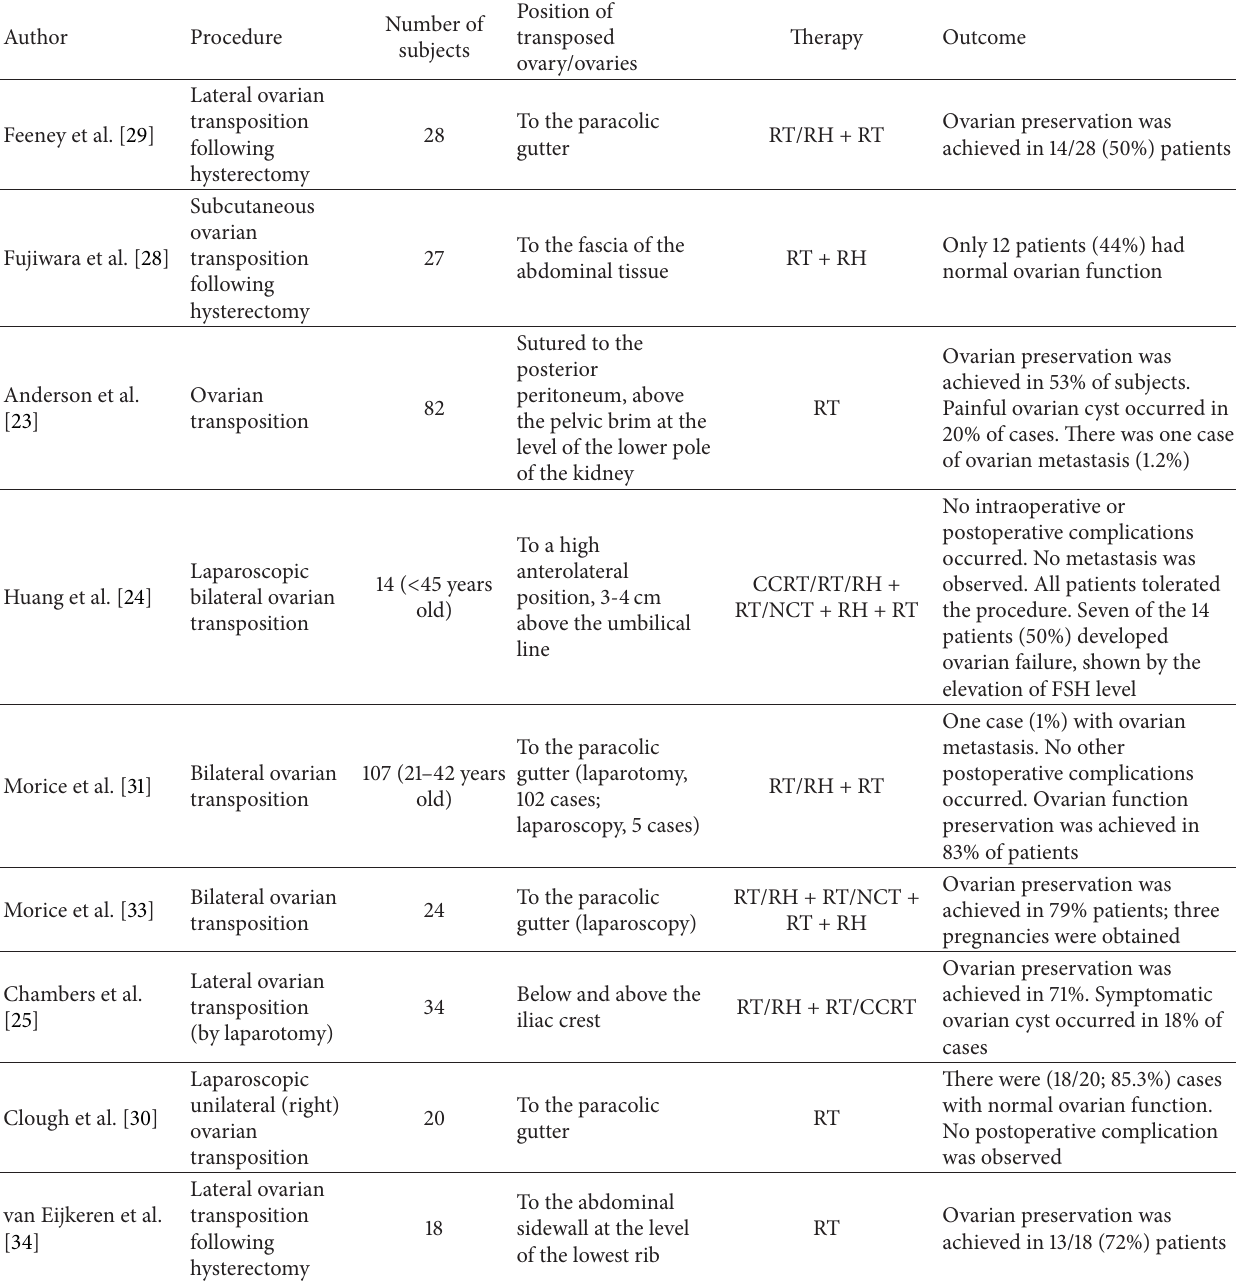
Table 1: Studies reporting the outcome of lateral ovarian transposition in patients with cervical